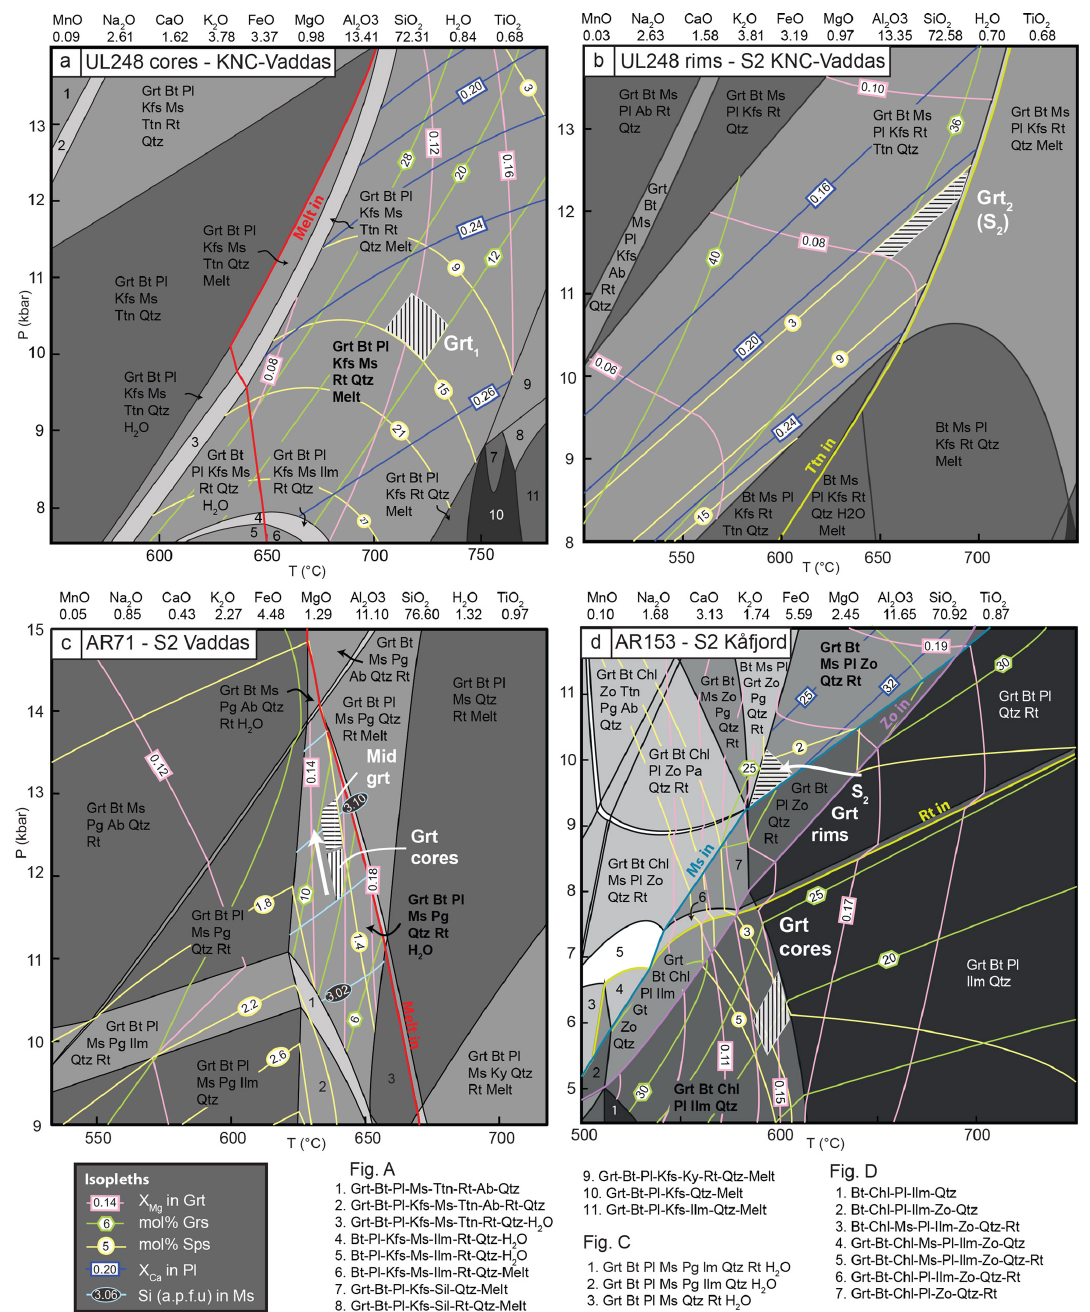
Figure 7. Pseudosections describing metamorphism at the Kalak–Vaddas nappe boundary (sample UL248) and in the Vaddas (sample AR71) and Kåfjord (sample AR153). Estimates in the pseudosections are displayed as striped boxes. (a) Garnet core (Grt 1 ) growth conditions